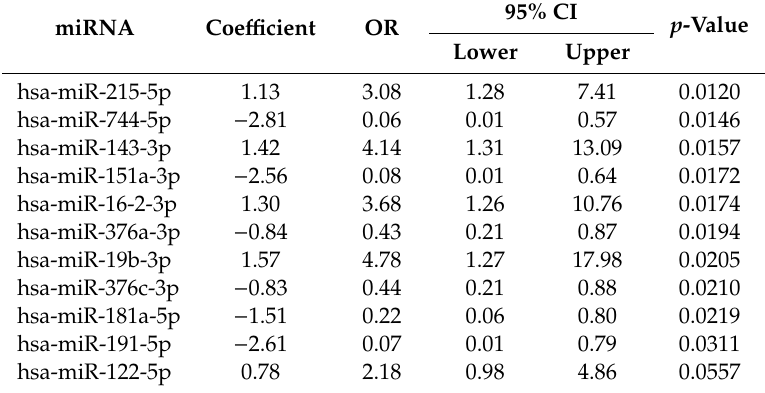
Table 3. Univariate logistic regression analysis for predicting refractoriness to bortezomib-based treatment in MM patients. miRNA